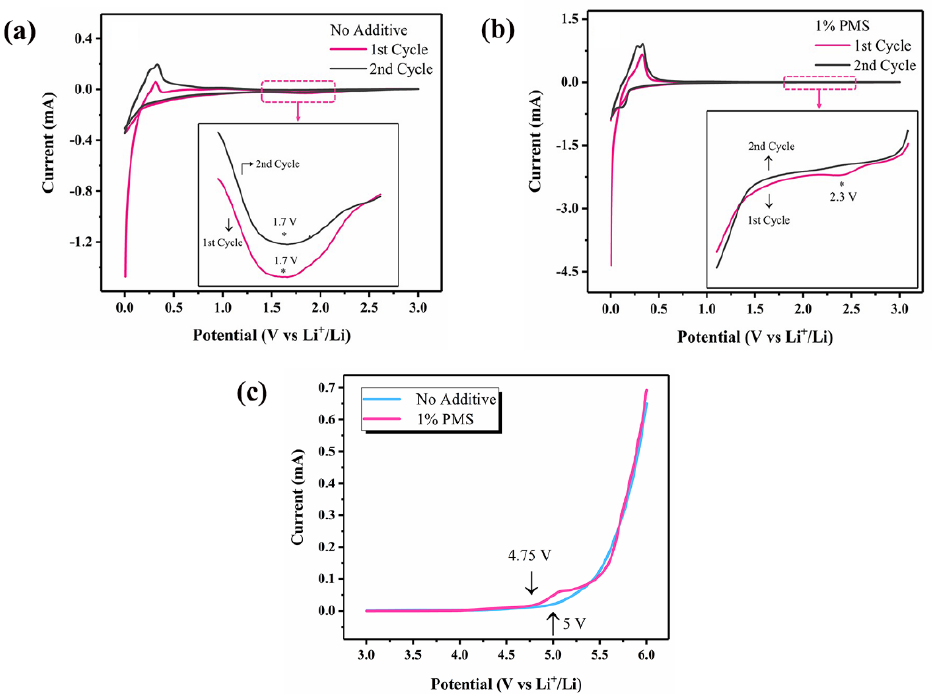
Figure 3. ( a ) The cyclic voltammograms of the Li/graphite half-cell in the electrolyte with no additive and ( b ) electrolyte with 1 wt% PMS. ( c ) The linear sweep voltammograms of the electrolytes without and with 1 wt%